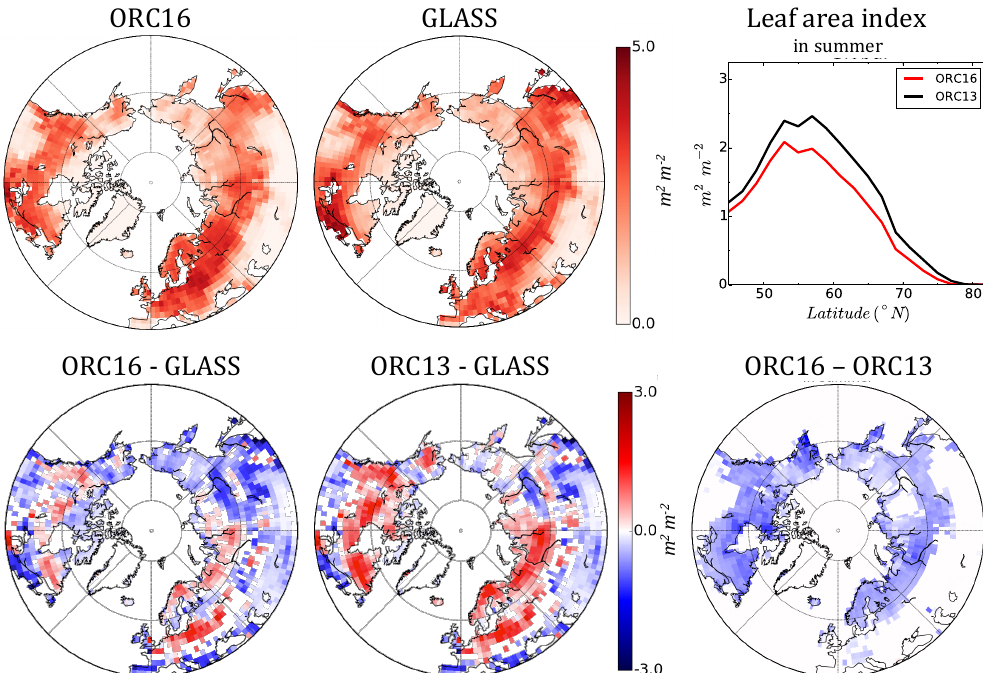
Figure 10. Global maps of LAI in summer (mean of July, August and September between 2004 and 2013) simulated by ORCHIDEE with the new PFTs (ORC16) and derived from satellite observations (GLASS LAI product, see Sect. 2.6.2), as well as the significant difference ( p value = 0.05) between the simulation with the new PFTs and the old 13 PFTs (ORC16 and ORC13 respectively), and the respective differences with the GLASS